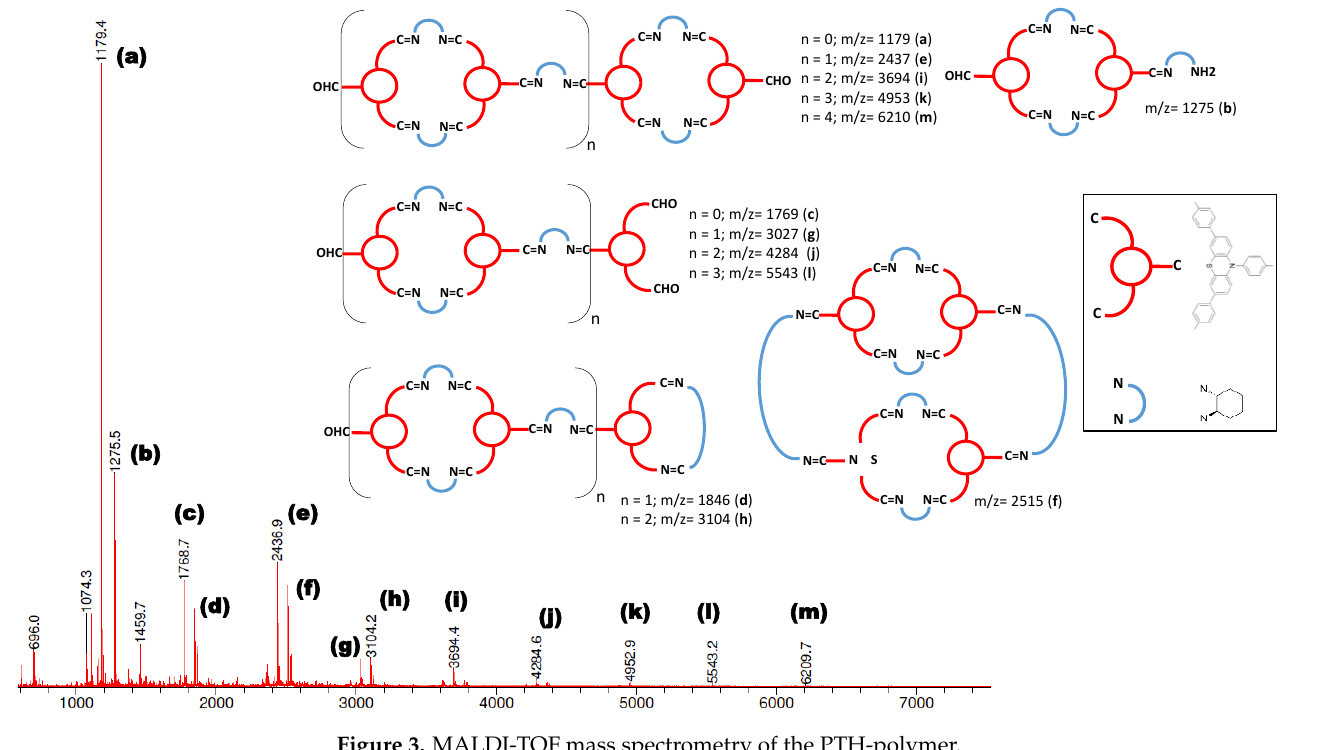
Figure 3. MALDI-TOF mass spectrometry of the PTH-polymer.